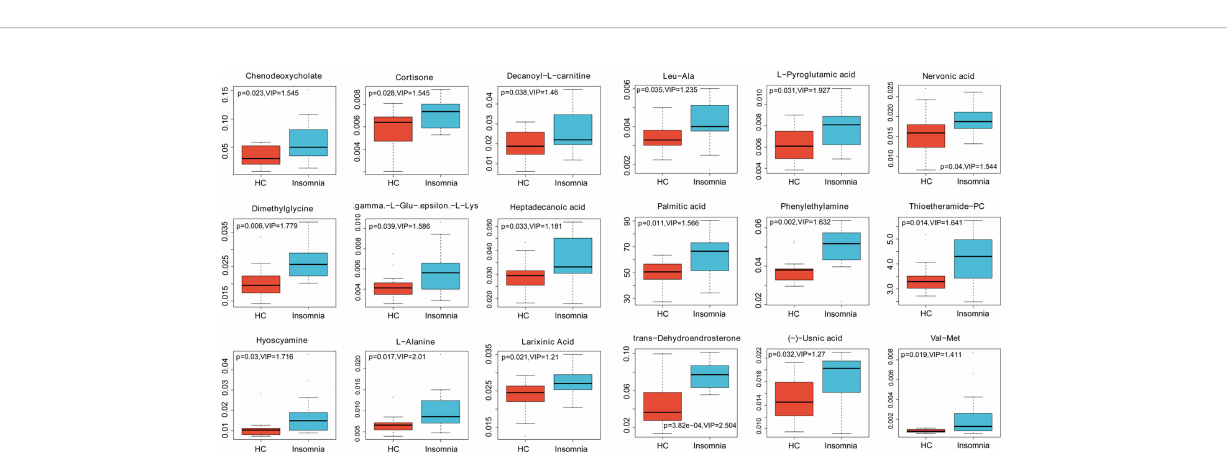
FIGURE 3 | Box plots (part I) of signi fi cantly changed metabolites identi fi ed in LC-MS analysis. Blue, patients with insomnia; Orange,